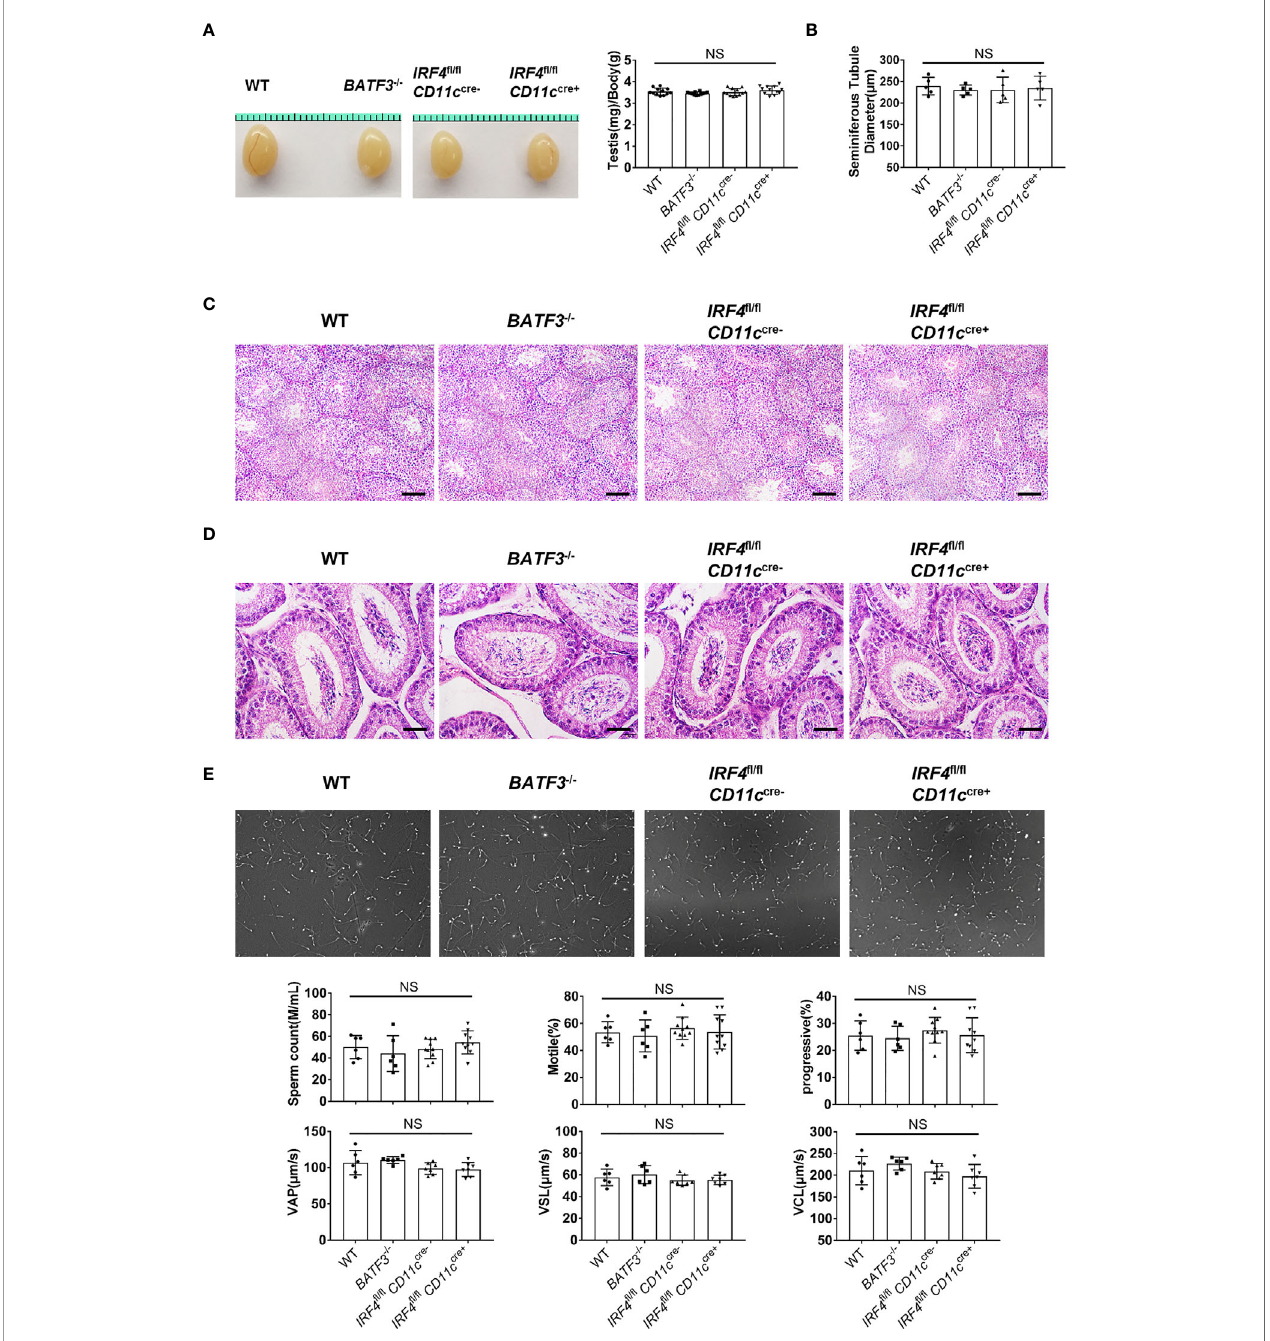
FIGURE 6 | Reduced T cells inthe testisdoes not hinder the testis development and spermatogenesis. (A) Gross morphologyof representative testis from 8-week-old WT, BATF3 − / − , IRF4 fl / fl CD11c cre − , and IRF4 fl / fl CD11c cre+ mice, and relative weight oftestis (testis weight (mg)/bodyweight(g)). n = 12. Data were pooled from two experiments. (B) Diametersof the seminiferoustubules of 8-week-old WT, BATF3 − / − , IRF4 fl / fl CD11c cre − , and IRF4 fl / fl CD11c cre+ mice. Each dot represents one mouse. n = 5. Data are representative of two experiments. (C) Hematoxylin-Eosin-stained testissectionsfrom 8-week-old WT, BATF3 − / − , IRF4 fl / fl CD11c cre − , and IRF4 fl / fl CD11c cre+ mice. Scale bar: 100 m m. (D) Hematoxylin-Eosin-stained epididymis sectionsfrom 8-week-old WT, BATF3 − / − , IRF4 fl / fl CD11c cre − , and IRF4 fl / fl CD11c cre+ mice. Scale bar:50 m m. (E) Sperm count, the ratioof motile sperm andprogressivesperm, and the velocity ofmotile sperm[VCL (curvilinear velocity), VSL (straight linevelocity), andVAP (averagepath velocity)] of indicatedmicewere detected bycomputer-assisted sperm analysis system.[n= 6 (WT, BATF3 − / − ),10 ( IRF4 fl / fl CD11c cre − , IRF4 fl / fl CD11c cre+ )]. Data are representative of two experiments. (A,B, E) Error barsare the mean ± SD.One-way ANOVA with Tukey ’ s multiplecomparisonstest was performed.NS, not signi fi